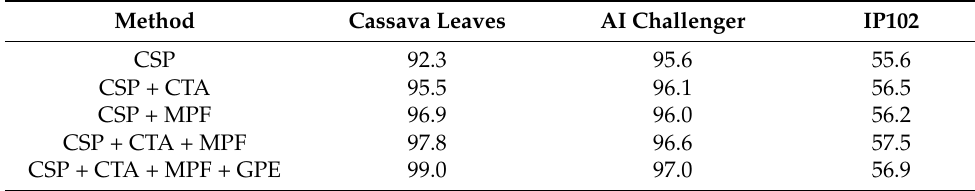
Table 4. Accuracy results of the ablation experiment.